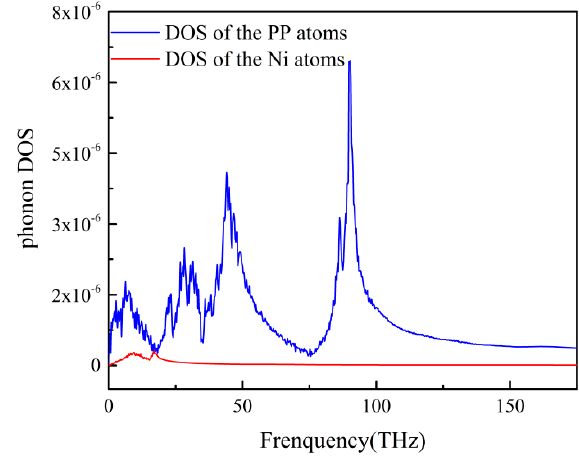
Figure 1. Non-equilibrium molecular dynamics (NEMD) simulation model for the polypropylene-nickel (PP-Ni) system and the temperature profile in a steady state.